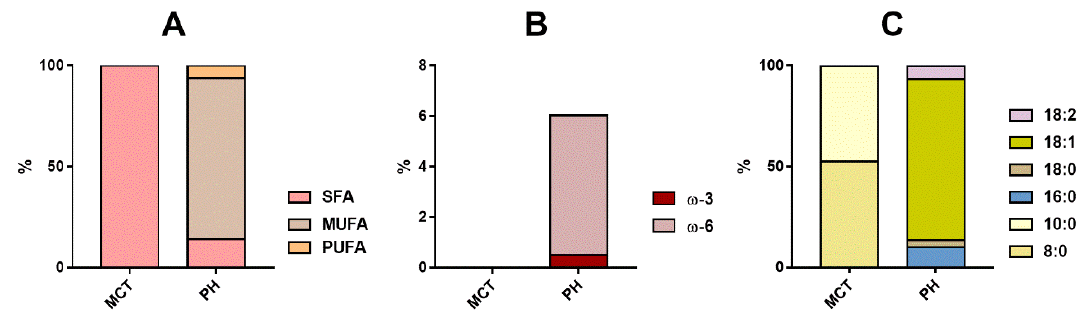
Figure 1. Fatty acid composition PhEur-grade olive oil (OOPH) and medium-chain triglyceride (MCT) oils. Comparison between the composition ( A ) in saturated (SFA) and unsaturated fatty acids (monounsaturated fatty acids, MUFAs; polyunsaturated fatty acids, PUFAs); ( B ) in omega-3 and omega-6 polyunsaturated fatty acids ( C ) in the main species of fatty acids. Data are expressed as percentage considering the mass of the individual fatty acids.